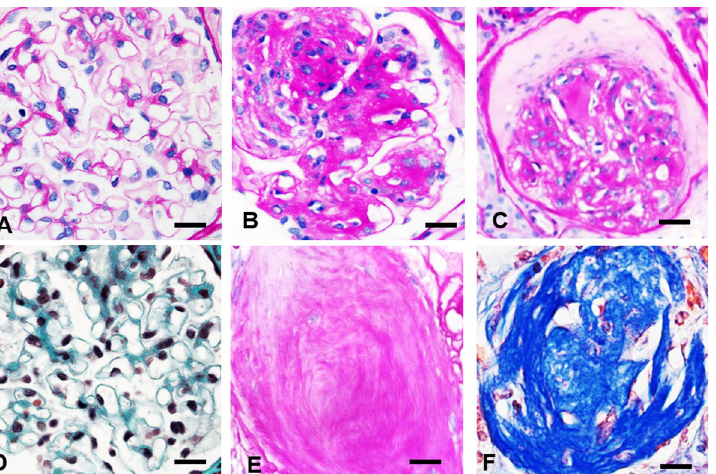
Fig 1. Criteria for hypertensive glomerulopathy in humans. A, D . Normal glomerulus. B In solidified glomeruli, mesangial widening results in prominent hyalinotic lesions and segmental sclerosis extending to Bowman’s capsule. Podocytes, mesangial and endothelial cells, capillary lumens gradually disappeared within expanding hyalinotic segments. C In ischemic glomeruli, the tuft retracted, capillary walls thickened while their lumens collapsed; hyalinosis and segmental sclerosis are less prominent. E, F Either solidified or ischemic glomeruli progress into the globally sclerotic lesion–acellular collagenous tufts. A—C, E –periodic acid–Schiff; D, F –Masson trichrome staining. x600.